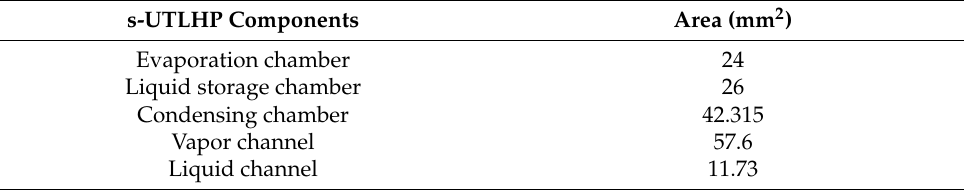
Figure 2. Structure diagram of the evaporator. Table 1. s-UTLHP dimension